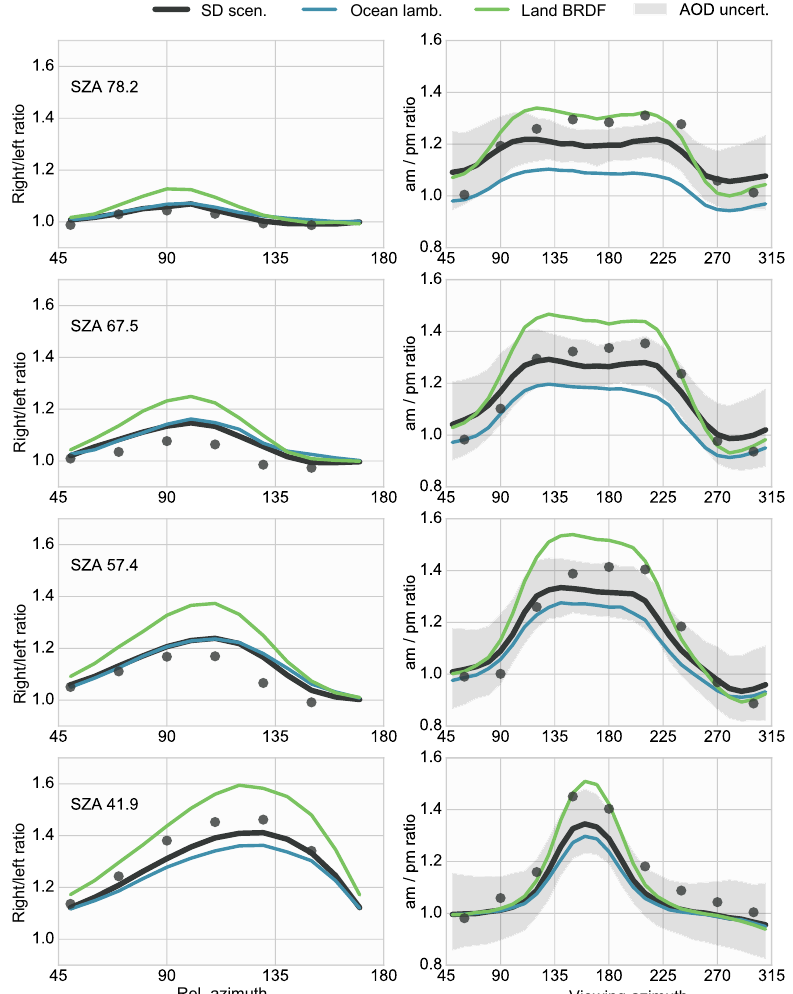
Figure 5. Investigating the impact on the right–left ratios (am) and am–pm ratios at 850nm for three model scenarios: modified land and ocean surface reflection models, and AOD uncertainty. The measurements are shown as dark circles for comparison. A difference of β of 0.01am to pm changes the radiance and hence the am–pm ratios by up to 10% (indicated as the grey band), which may explain the discrepancy of the standard model scenario with the measurements. The right–left ratios are not affected by AOD uncertainty and are therefore a good indicator that the pasture land BRDF is less appropriate here. The ocean BRDF only has an effect at high